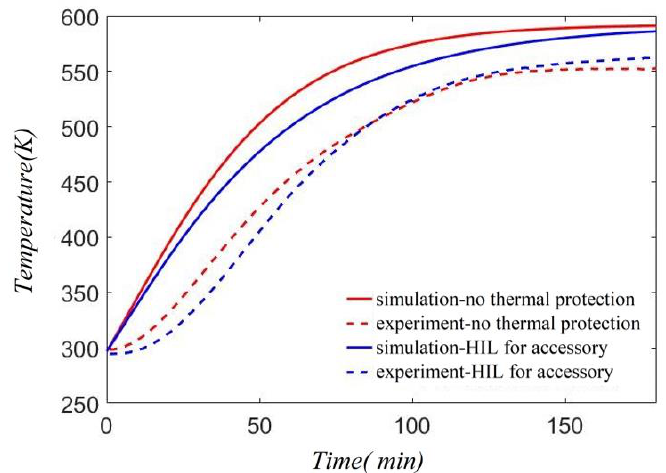
Figure 10. Comparisons between the experimental results and the numerical results for an accessory in the ramjet engine.